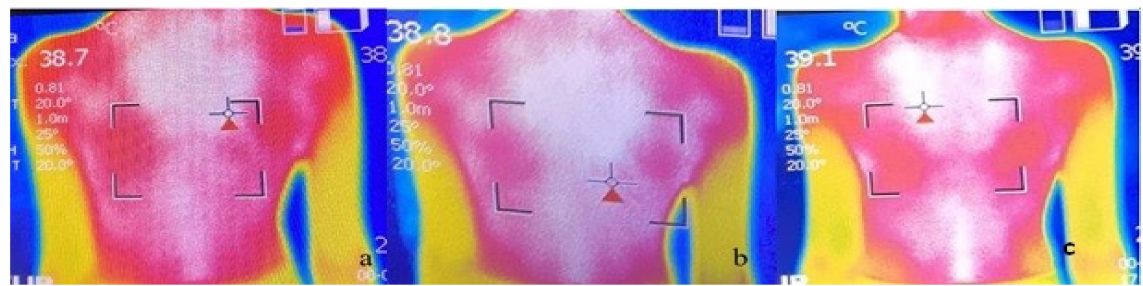
Figure 9. Subject with scoliosis 2 ( a ) image taken at the begining of the experiment 1; ( b ) image taken at the end of the experiment 1; ( c ) image taken at the the end of the experiment 2.